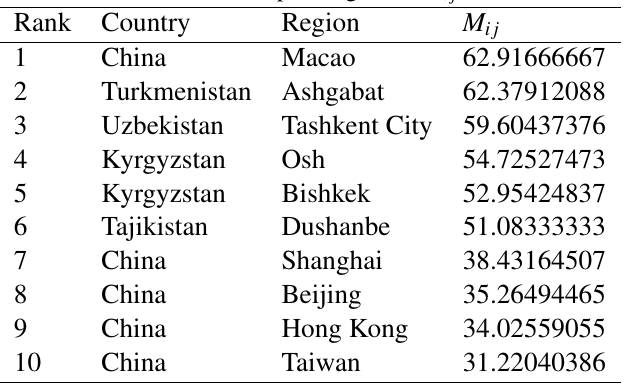
Table 1 Top 10 region of M ij